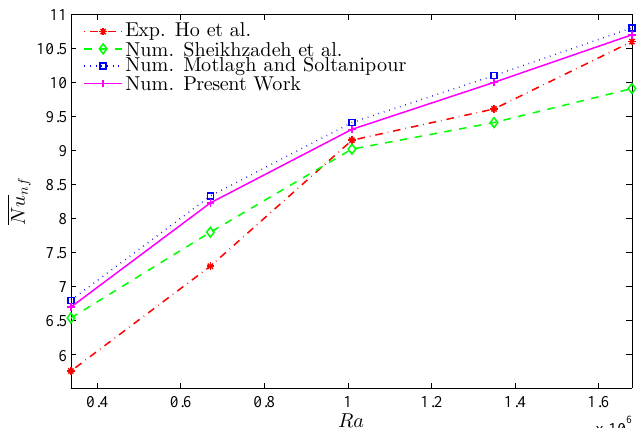
Figure 3. Comparison between the experimental and numerical results for the average Nusselt number for different values of the Rayleigh number.